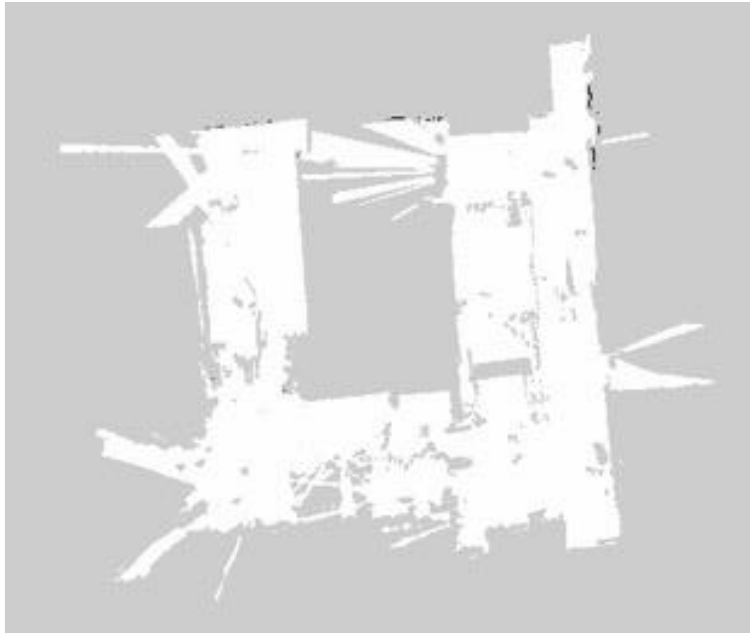
Figure 24. The map using Hector (YDLiDAR X4).